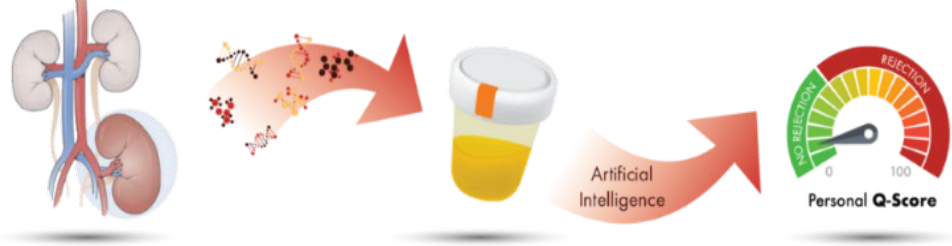
Figure 2. The QSant test is designed to quantitatively measure acute kidney transplant rejection using patient urine samples. The test measures six urinary biomarkers: cell-free DNA (cfDNA), methylated cfDNA (m-cfDNA), clusterin, CXCL10, creatinine, and total protein in renal transplant patients. The six-biomarker data are integrated into an algorithm to calculate a composite kidney rejection risk score, Q-Score, from a scale of 0–100 to reflect the probability of allograft rejection risk.